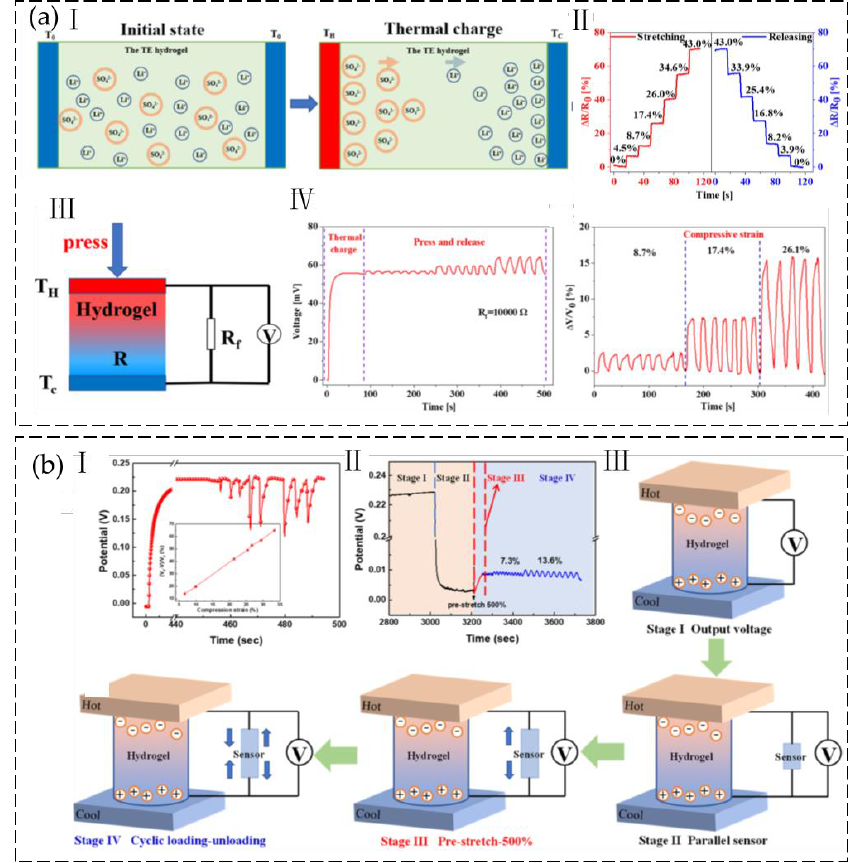
Figure 14. ( a ) Ⅰ . Thermal voltage generation mechanism of thermodiffusion of ions. Ⅱ . Relative re- Figure 14. ( a ) I. Thermal voltage generation mechanism of thermodiffusion of ions. II. Relative sistance change during stretching and releasing. Ⅲ . Schematic illustration of the thermo-powered resistance change during stretching and releasing. III. Schematic illustration of the thermo-powered ionic hydrogel strain sensor. Ⅳ . Thermal charge and voltage changes during compression and re- ionic hydrogel strain sensor. IV. Thermal charge and voltage changes during compression and laxation. (Reprinted with permission from [98] .) ( b ) Ⅰ . Voltage changes of the hydrogel at various relaxation. (Reprinted with permission from [98].) ( b ) I. Voltage changes of the hydrogel at various compressive strai ns with a ΔT of 7.5 K. Ⅱ . The voltage changes of the hydrogel sensor in parallel compressive strains with a ∆ T of 7.5 K. II. The voltage changes of the hydrogel sensor in parallel with with thermoelectric hydrogels at various tensile strains. Ⅲ . Corresponding equivalent circuit dia- thermoelectric hydrogels at various tensile strains. III. Corresponding equivalent circuit diagram. gram. (Reprinted with permission from [99] .) (Reprinted with permission from